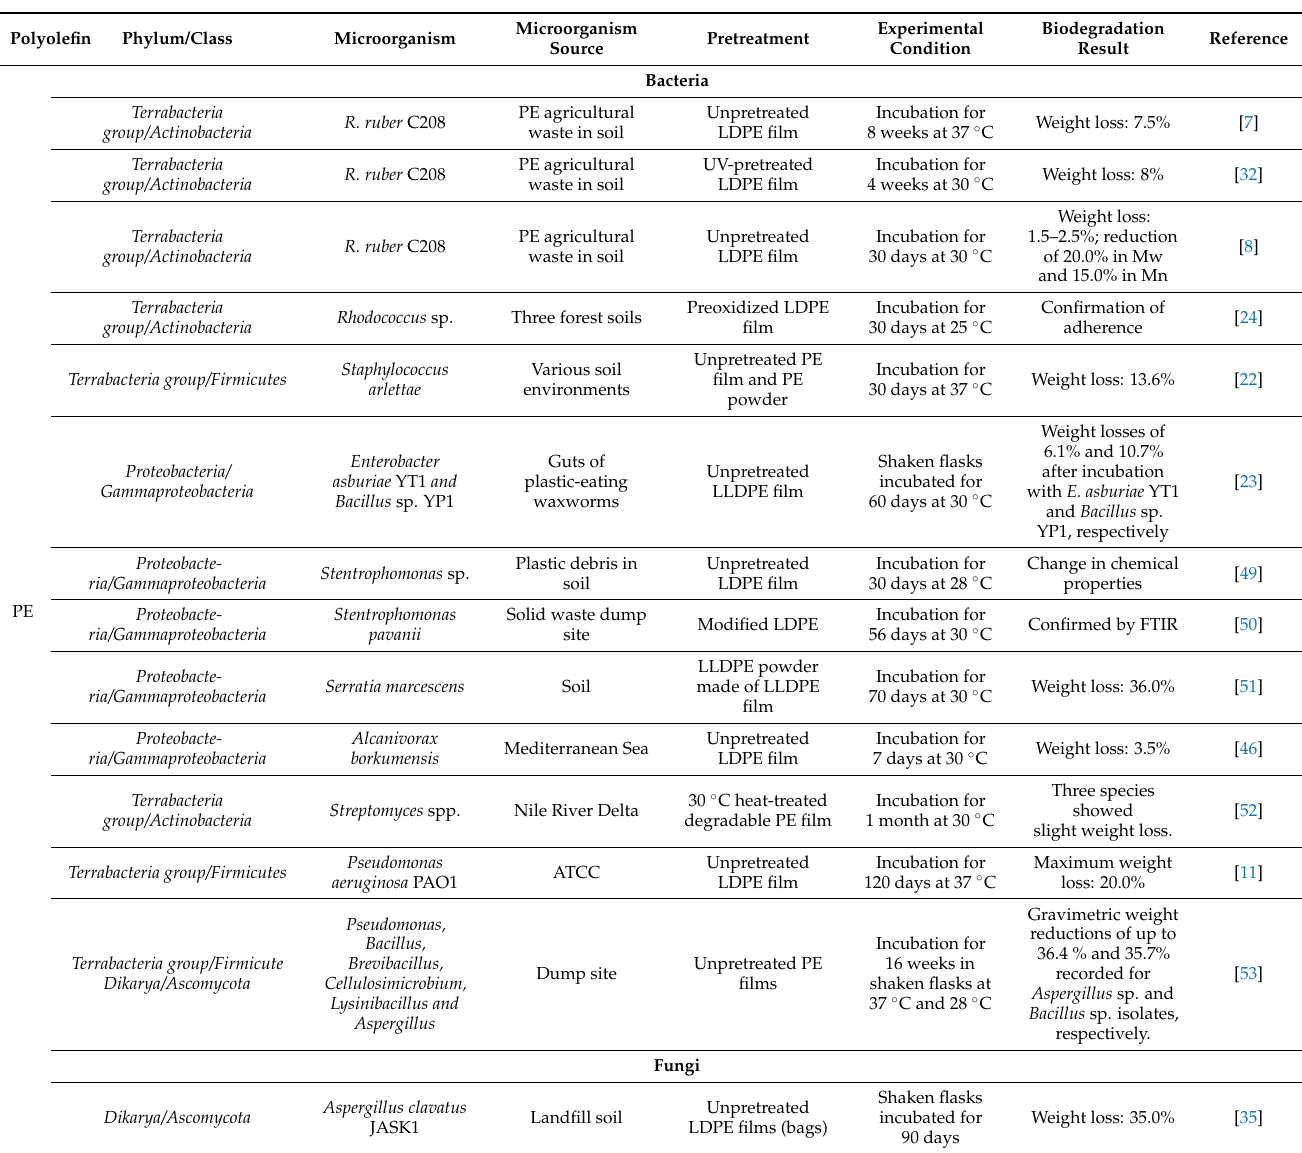
Table 1. Wild strains capable of polyolefin